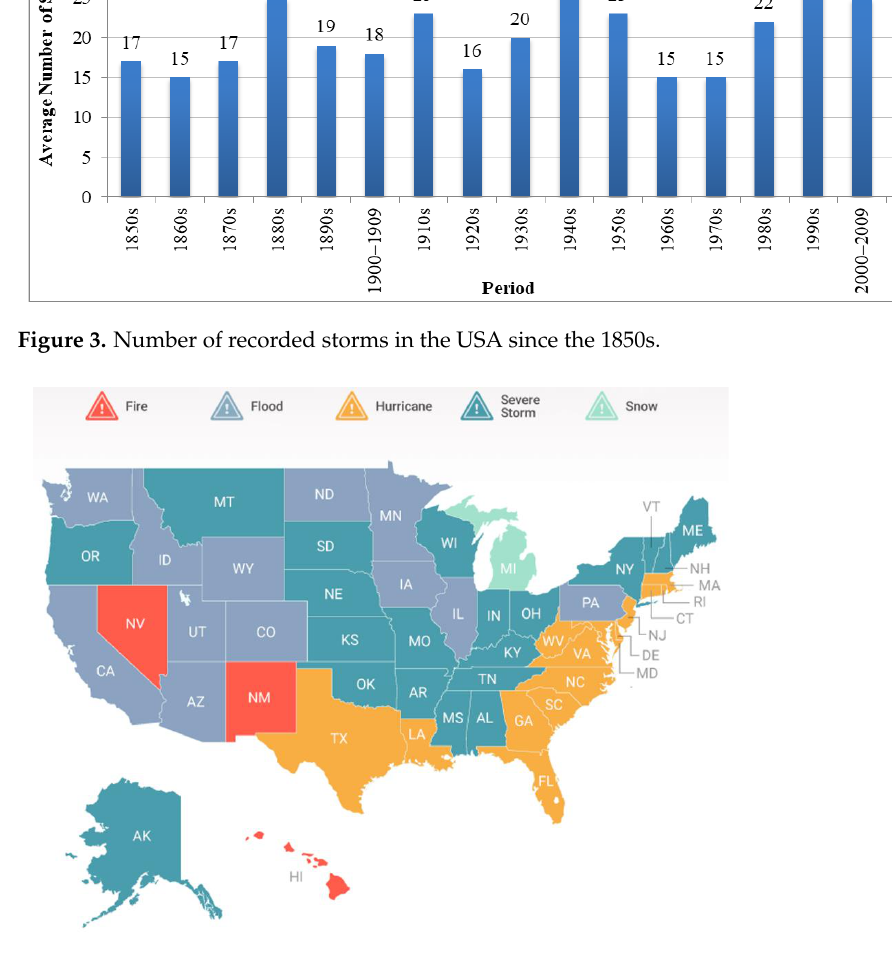
Figure 4. Natural disaster declarations in the USA states. Source: FEMA